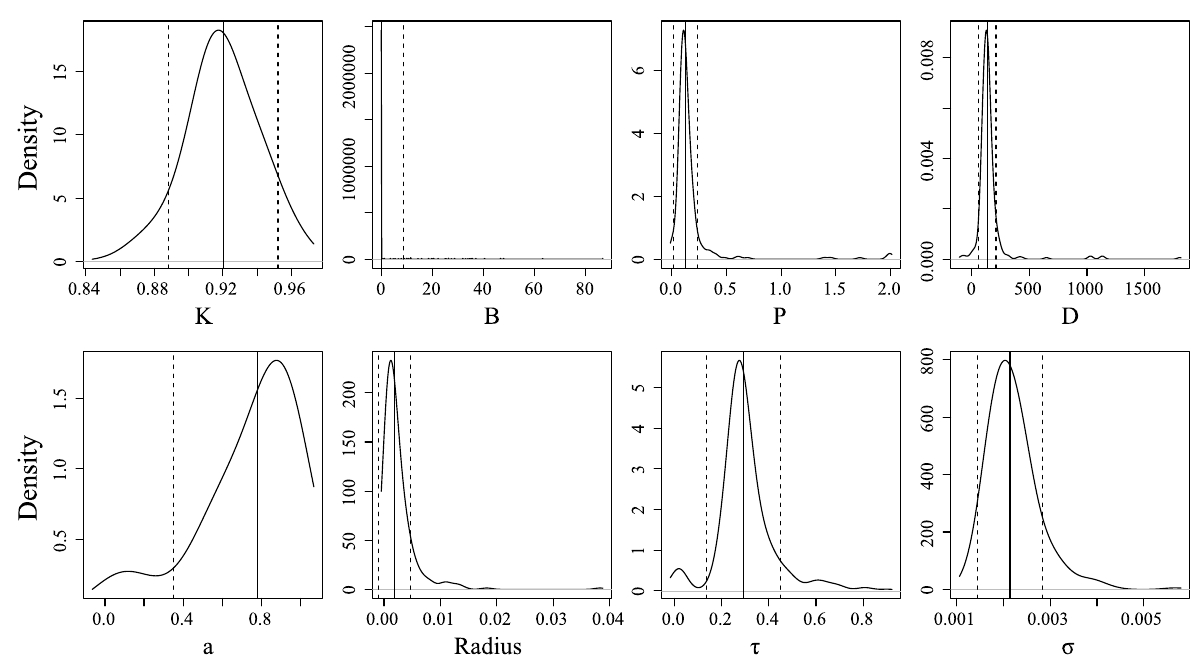
Fig 9. Marginal distributions of the ISDDE parameter estimates. Solid lines are means and dashed lines are standard deviations, both trimmed for the 15 highest values.